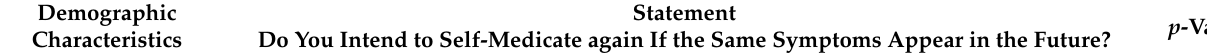
Table 5. Public reported outcomes for the participants in the